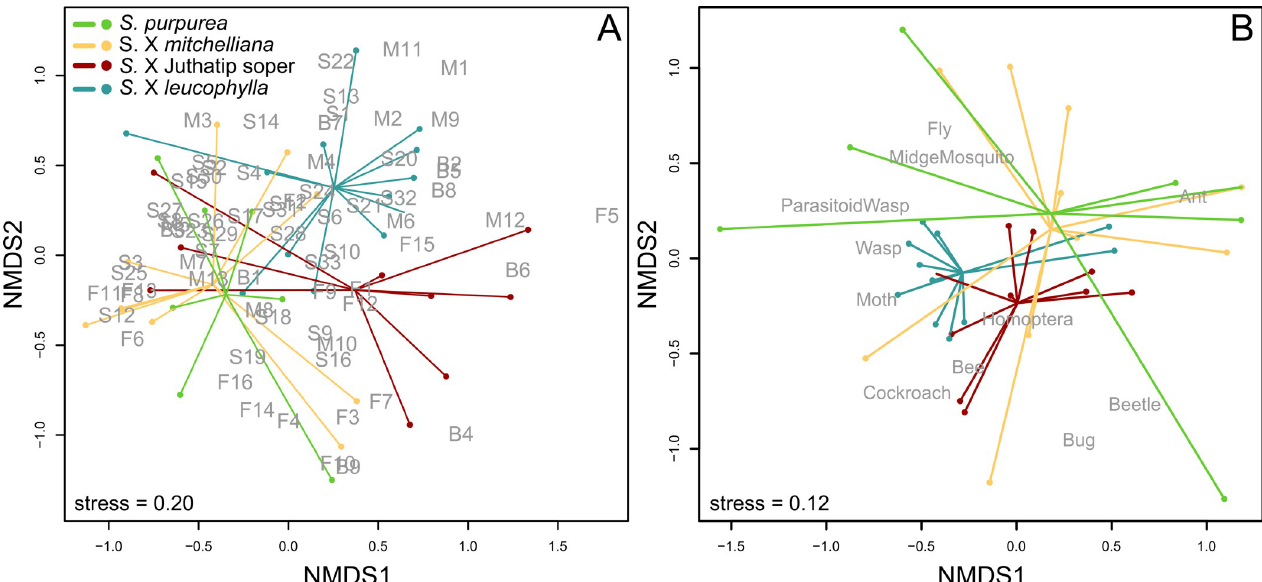
Fig 2. Similarity analyses of odour and prey composition of the Sarracenia taxa. Distribution of Sarracenia pitchers according to the similarity of their odour (A) and prey (B) spectra in terms of relative amounts of VOCs emitted and prey groups captured, respectively. The non-metric multi-dimensional scaling (NMDS) based on Bray-Curtis dissimilarity index showed a globally significant difference between Sarracenia taxa for both odour and prey spectra according to permutational multivariate analyses of variance considering also the effect of plant identity (P < 0.001 in each case, see S2 Table for pairwise comparisons). The stress value was given to evaluate the quality of the ordination fit to the observed data. The VOCs are referred as Fi, Bi, Mi, Si, where i is the COV number and F, B, M and S refer to Fatty acid derivatives, Benzenoids, Monoterpenes and Sesquiterpenes respectively.